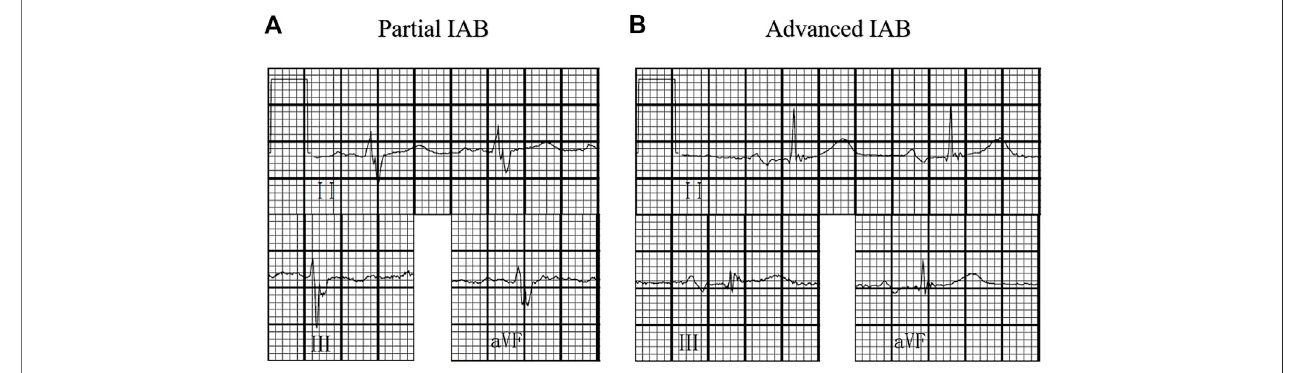
FIGURE 1 | Interatrial block (IAB) degree. (A) partial IAB:P wave ≥ 120 ms without bimodal morphology; (B) advanced IAB:P wave ≥ 120 ms with bimodal morphology in inferior leads.